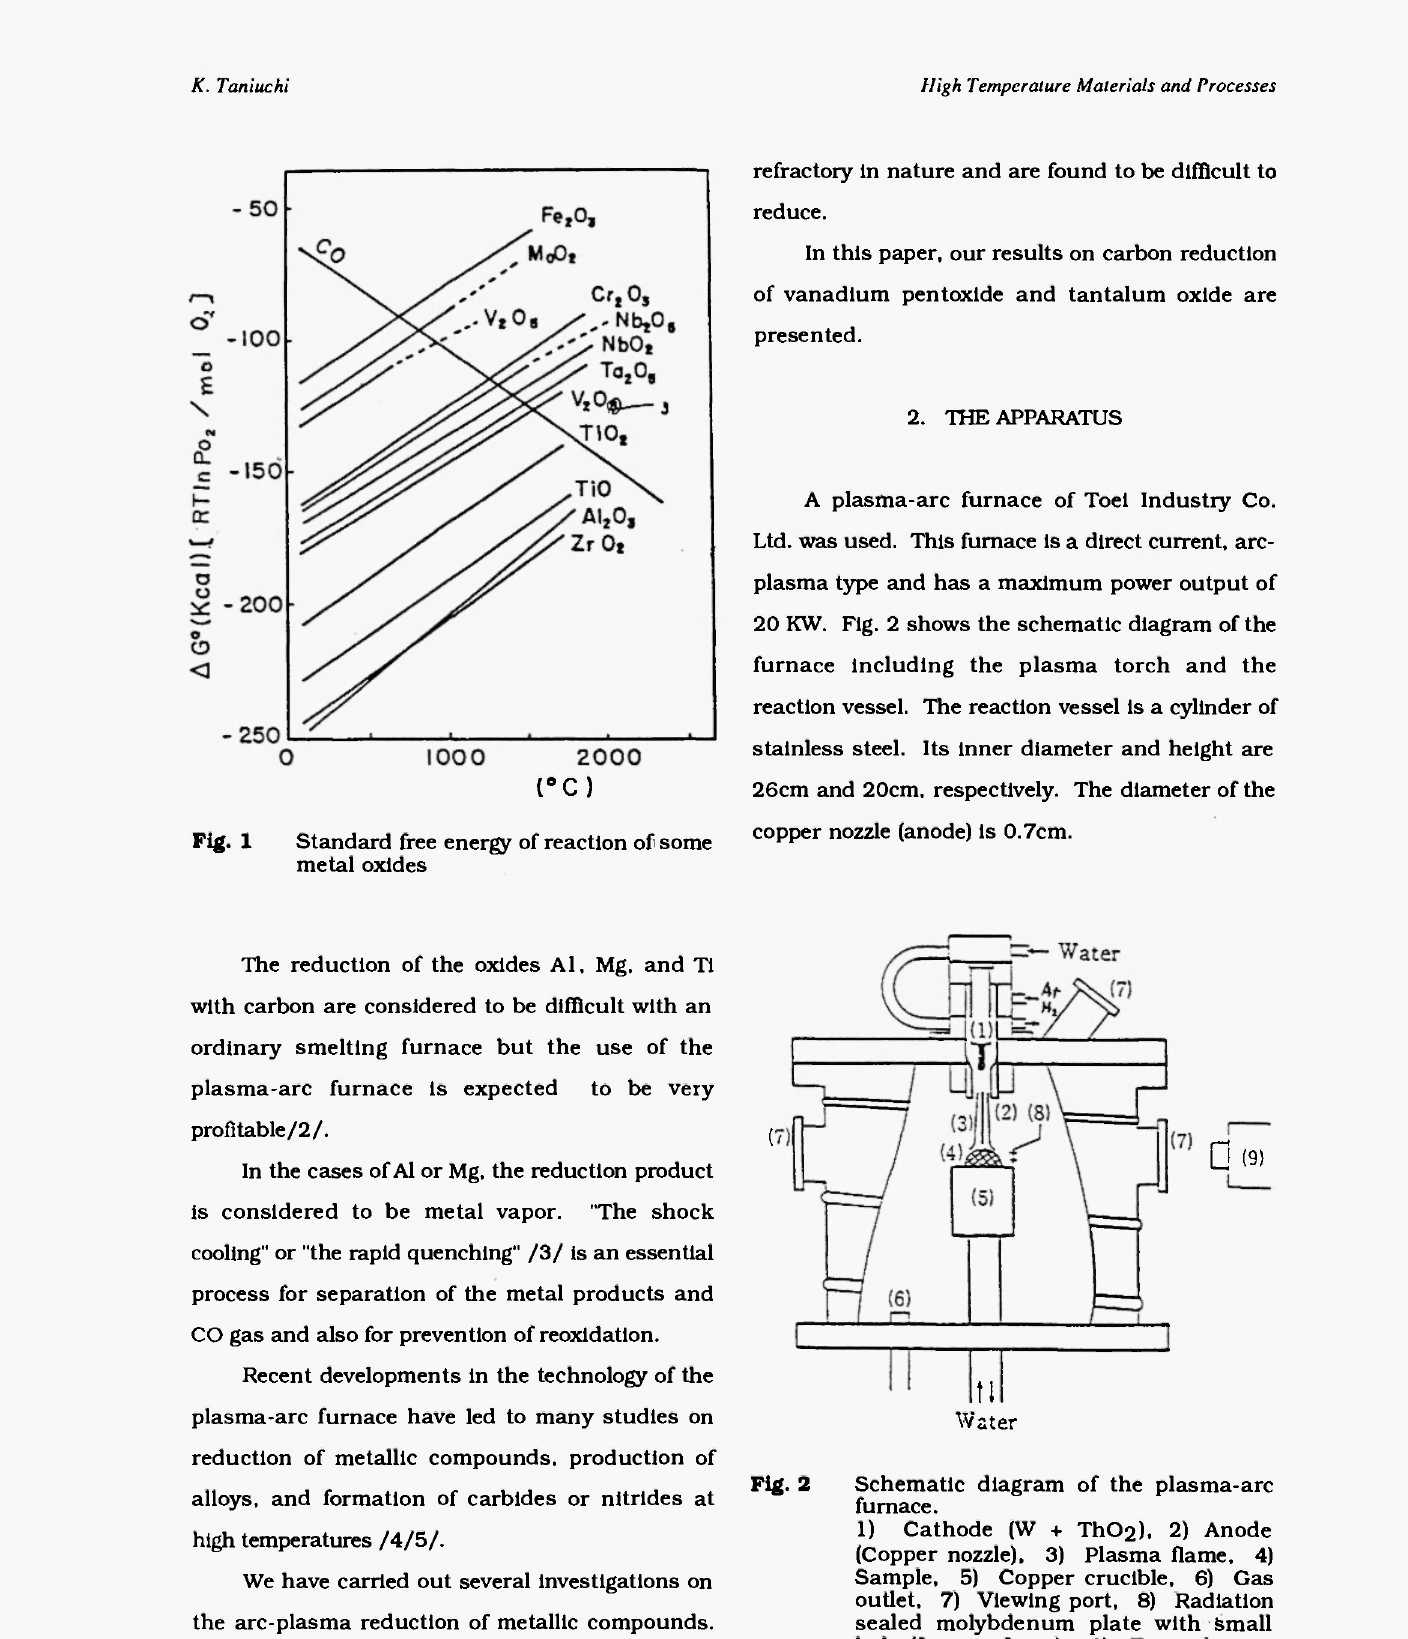
Fig. 2 Schematic diagram of the plasma-arc furnace. 1) Cathode (W + ThC>2). 2) Anode (Copper nozzle), 3) Plasma flame, 4) Sample, 5) Copper crucible, 6) Gas outlet, 7) Viewing port, 8) Radiation sealed molybdenum plate with ämall hole (2mm χ